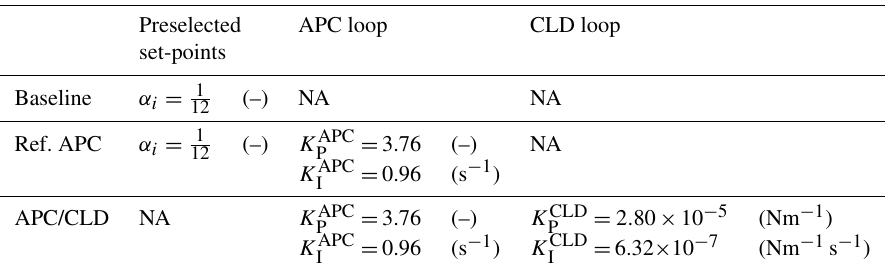
Figure 8. Normalized RegD type of an (automatic generation control) AGC test signal (data obtained from https://www.pjm.com/, last access: 18 April 2017). Table 3. The key parameters of the implemented active power controllers at the wind farm level in PALM. The wind turbine control system frequency and damping ratio are chosen as ω = 0 . 06Hz and ζ =